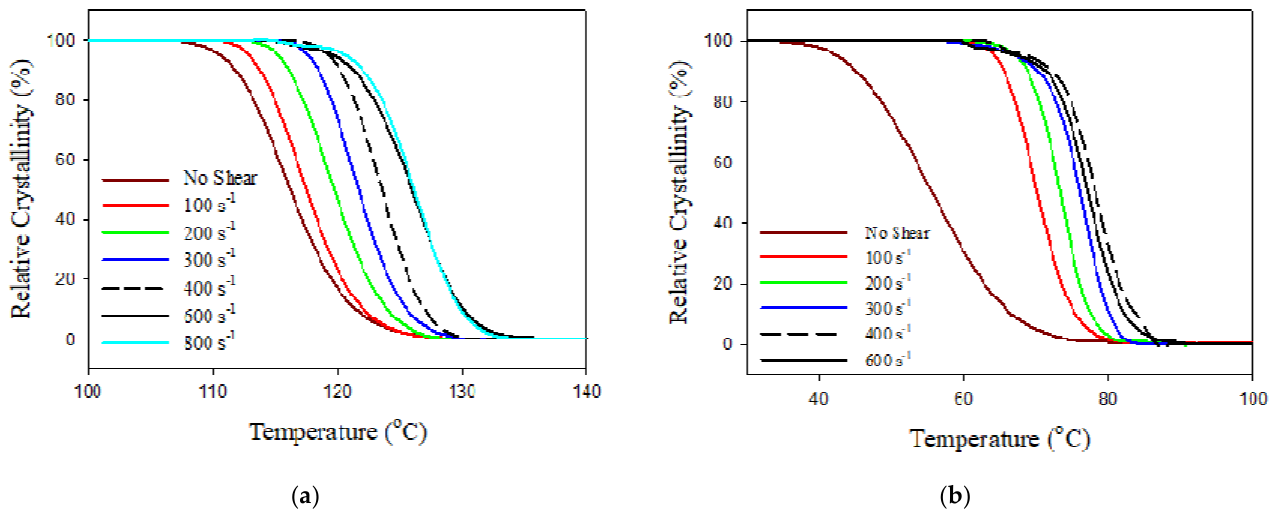
Figure 2. Temperature dependencies of conversion degree for ( a ) PBASGT and ( b ) PBAT specimens sheared for 45 s during cooling at 20 °C/min. The shearing with different rates in the range of 100–800 s −1 was initiated at 220 °C.